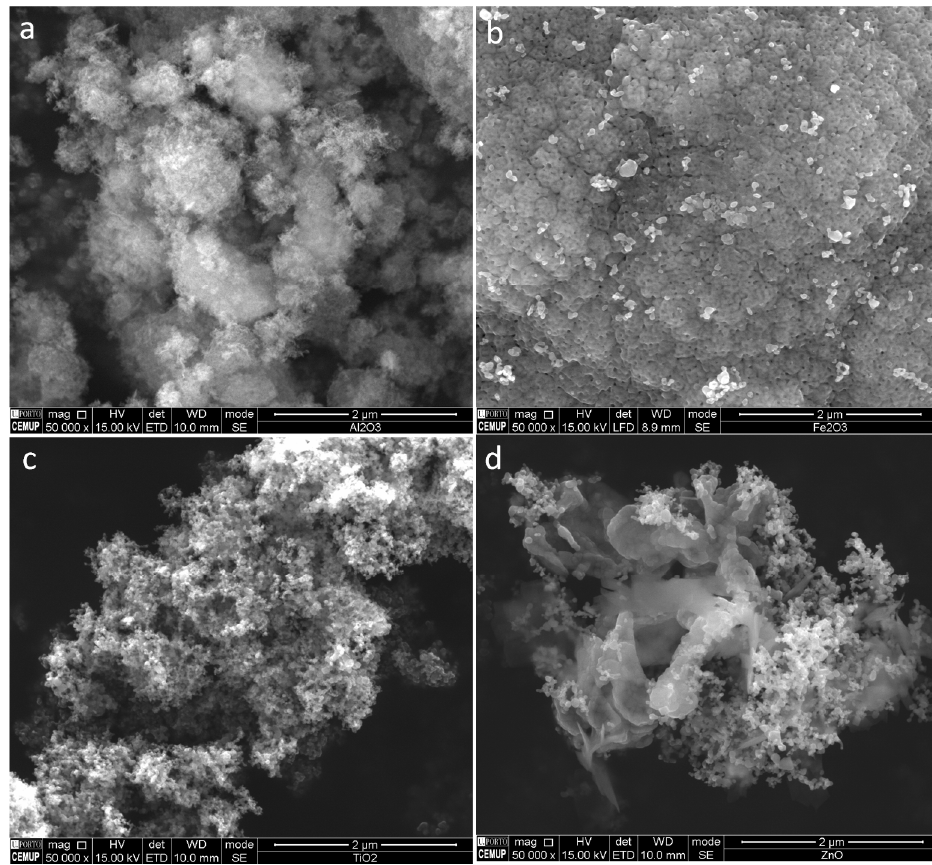
Figure 1. The SEM images of supports: ( a ) Al 2 O 3 , ( b ) Fe 2 O 3 , ( c ) TiO 2 , ( d )